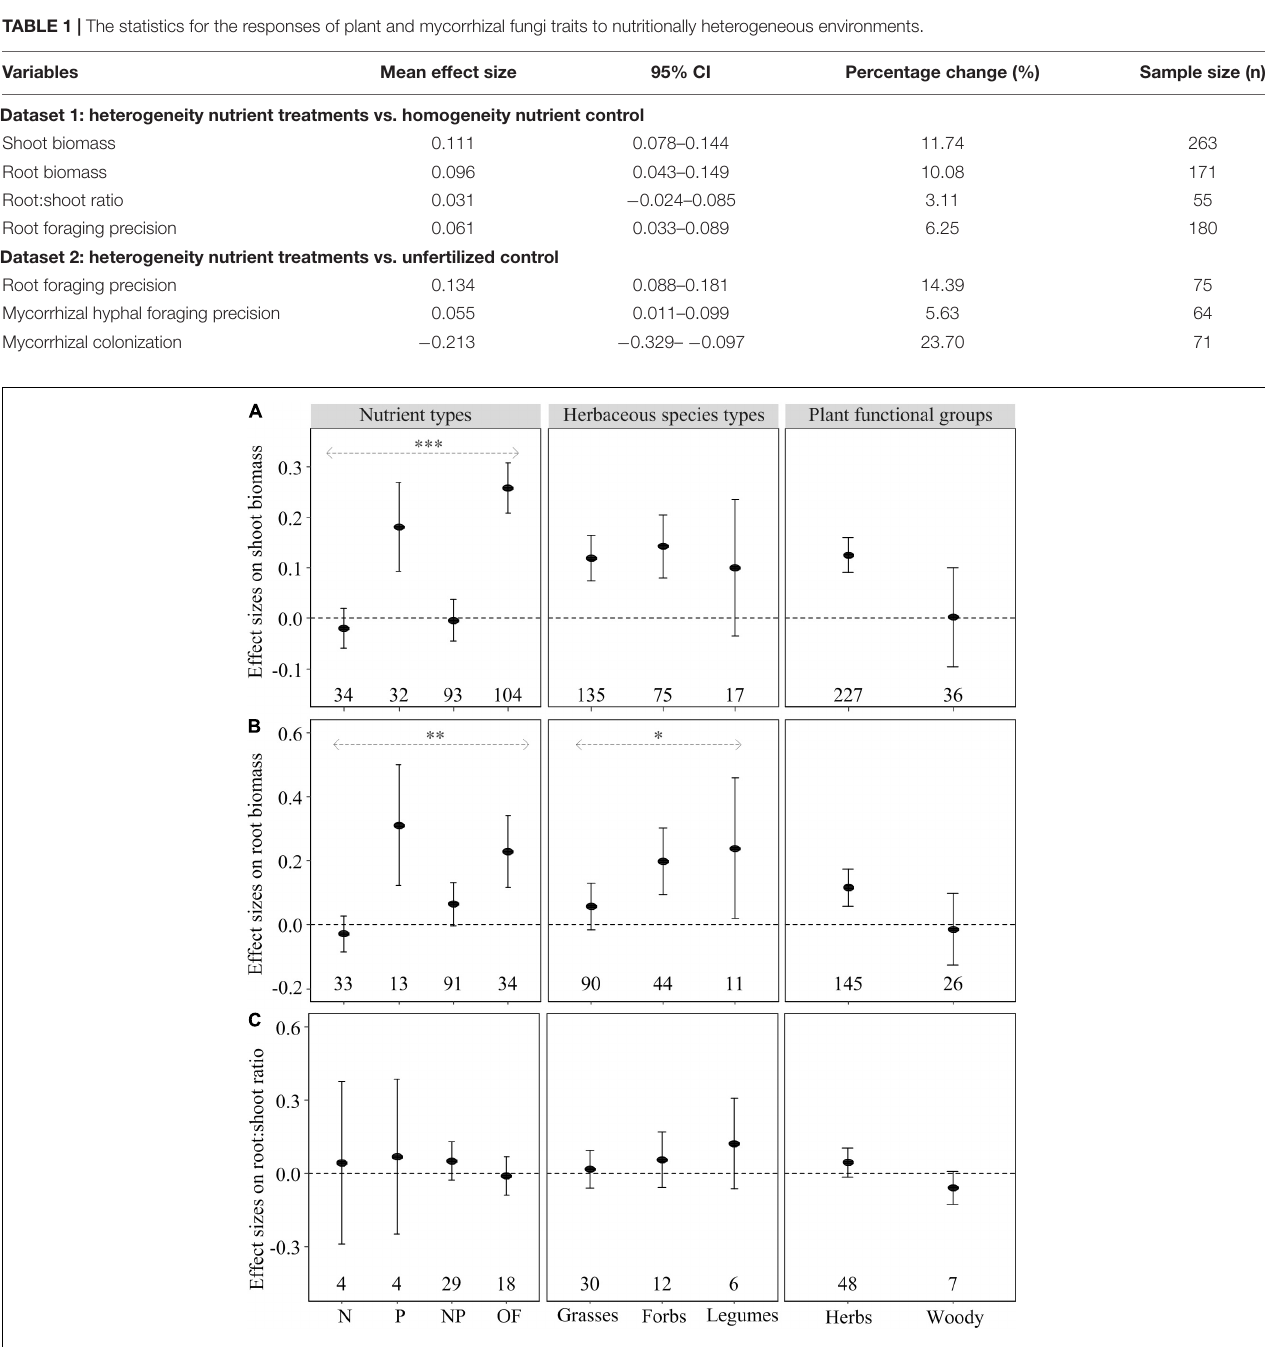
FIGURE 1 | Mean effect sizes (closed circles) of the heterogeneous nutrient supply effects on shoot biomass (A) , root biomass (B) , and root:shoot ratio (C) as influenced by nutrient types (N, P, NP, or OF = organic fertilizer or organic matter), herbaceous species types (grasses, forbs, and legumes), and plant functional groups (herbs and woody) based on the first dataset. Error bars represent ± 95% confidence intervals. Effects are significant if confidence intervals (95% CI) for a given parameter do not overlap with zero. Mean effect sizes < 0 represent a reduction (and > 0 an increase) in plant growth in nutritionally heterogeneous environment compared with homogeneous environment. The numbers under the CI bars represent the sample sizes. The asterisks denote significant difference among the categories. ∗ P < 0.05; ∗∗ P < 0.01; ∗∗∗ P <